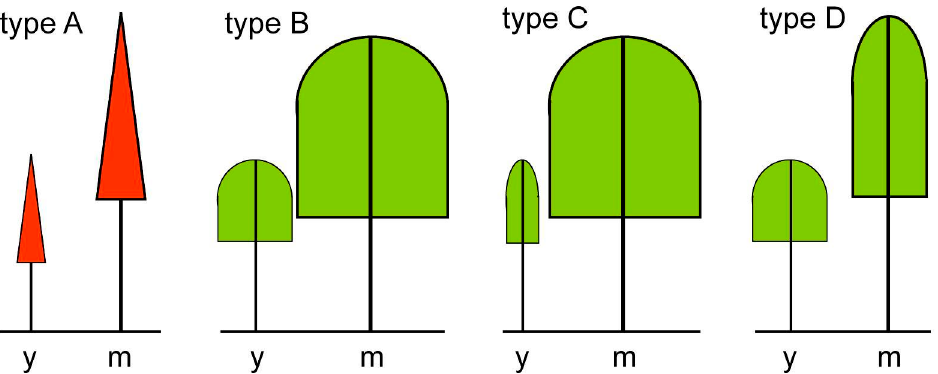
Figure 3. Visualization of 4 basic types of crown width allometry (cpa = a × d α cpa,d ) from the young (y) to the mature (m) tree development phase. ( a ) Continuously slim crown from young to mature phase, associated with low a cpa,d and low α cpa,d values (see curves A in Figure 2a,b). ( b ) Continuously large crown from the young to the mature phase, associated with high a cpa,d and low α cpa,d values (see curves B in Figure 2a,b). ( c ) Initially small crown extending with progressing size growth associated with low a cpa,d but high α cpa,d values (see curves C in Figure 2a,b). ( d ) Relatively large crowns in the young phase and just moderate extension with further size development, associated with high a cpa,d but low α cpa,d values (see curves D in Figure 2a,b).